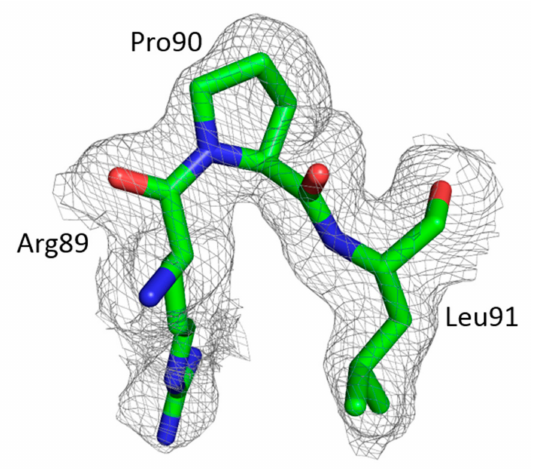
Figure 4. Omit map of FIV CA Arg89-Pro90 cis -peptide bond from chain B CypA-BL, contoured at 1 σ . The oxygen and nitrogen atoms are shown in red and blue,